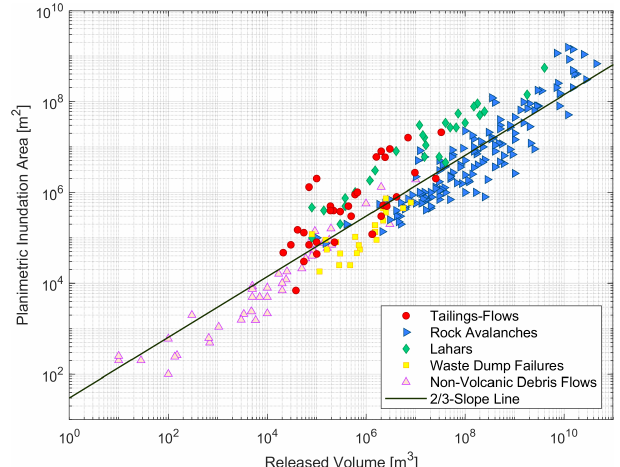
Figure 9. Comparison of the runout inundation area as a function of flow volume for tailings flows (red symbols; n = 33)), waste dump failures (yellow symbols; n = 22), lahars (green symbols; n = 27), non-volcanic debris flows (pink symbols; n = 44), and rock avalanches (blue symbols; n = 142). The black two-thirds slope line is drawn as a guide for visual comparison